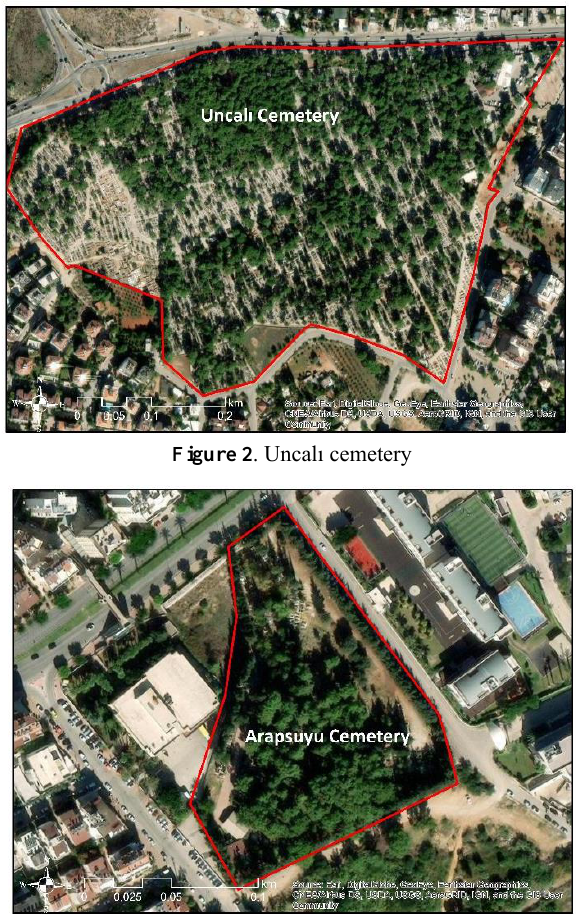
Figure 3 . Arapsuyu cemetery